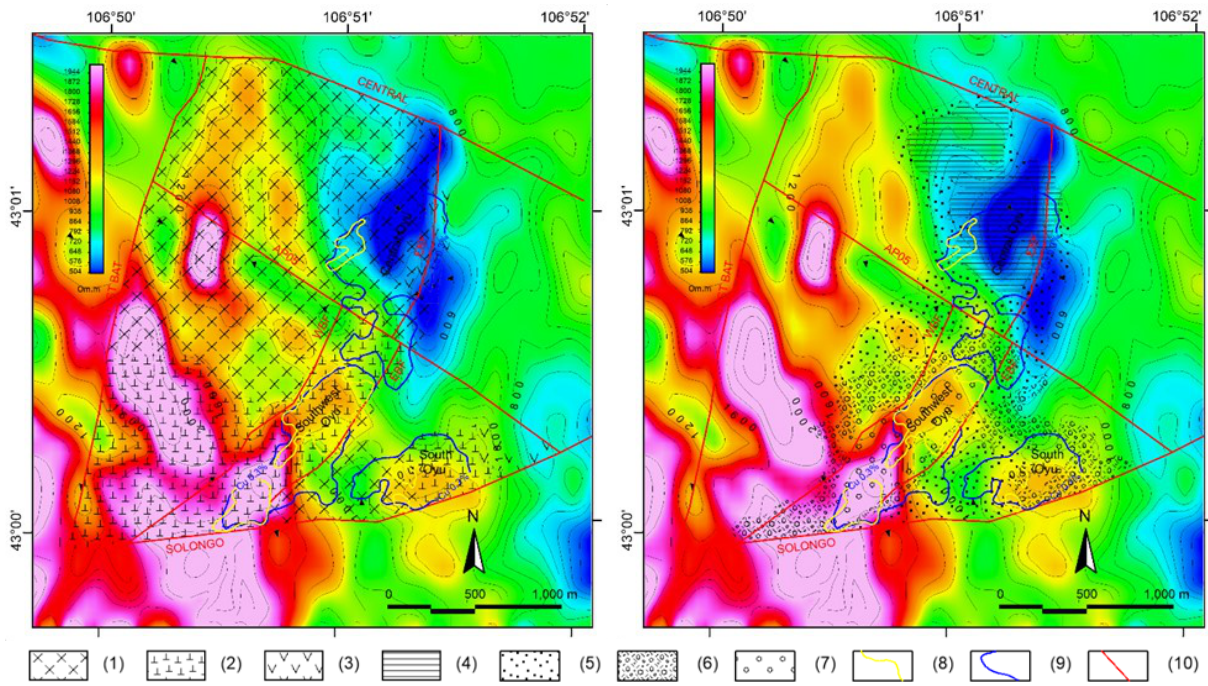
(1) Quartz-monzodiorite;; (2) Augite Basalt; (3) Ignimbrite; (4) Advanced Argillic alteration zone; (5) Phyllic alteration zone; (6) Prophyllitic alteration zone; (7) Potassic alteration zone; (8) Gold grade isoline – 0.3 ppm; (9) Copper grade isoline – 0.3%; (10) Fig. 5. Induced Polarization survey results (AB = 11000, MN=100): Resistivity overlapping with lithology (left), and resistivity overlapping with alteration zones (right);